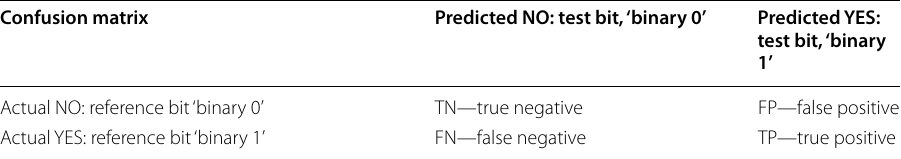
test bit, ‘binary 1’